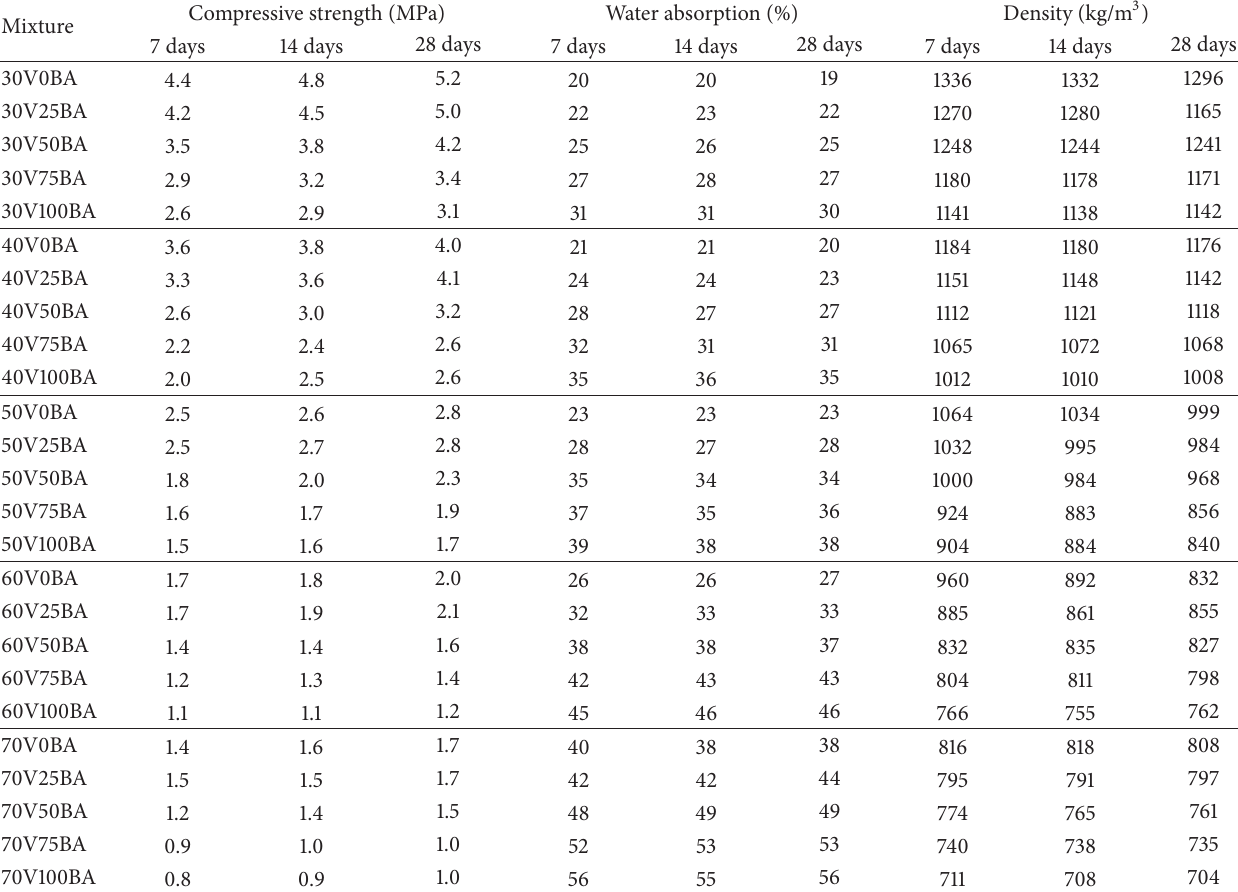
Table 3: Compressive strength, water absorption, and density of cellular concretes.